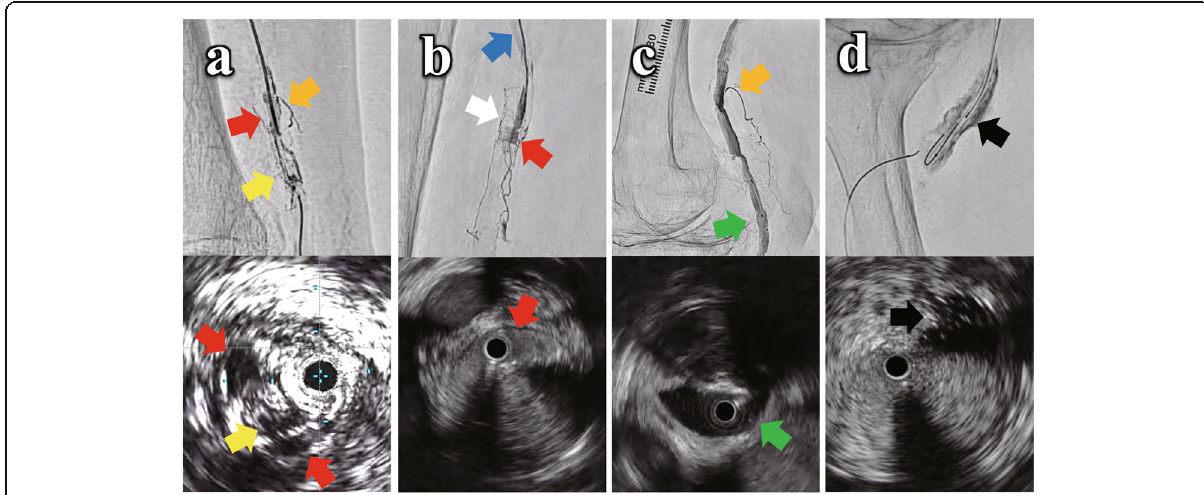
Fig. 1 The four typical angiographic images by the “ Direct tip Injection in Occlusive Lesions (DIOL) ” fashion. A Intimal injection: microchannels which are tiny and relatively straight route without contrast stain (yellow arrow), the branch which is connected with microchannels created by an intimal injection (orange arrow), and a “ tubular ” dissection which is a subintimal space connected with microchannels (red arrow). B Subintimal injection: a “ tubular ” dissection (red arrow). A vasa vasorum (white arrow), a venous vasa vasorum, and veins (blue arrow), which are connected among them, are occasionally seen by a forceful injection in subintima. C Intramedial injection: a “ river ” dissection (green arrow), and the branch which is connected with intramedial